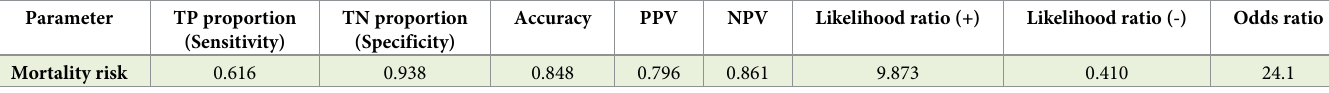
Table 6. Prognostic evaluation of combined parameters for mortality from the disease. Parameter